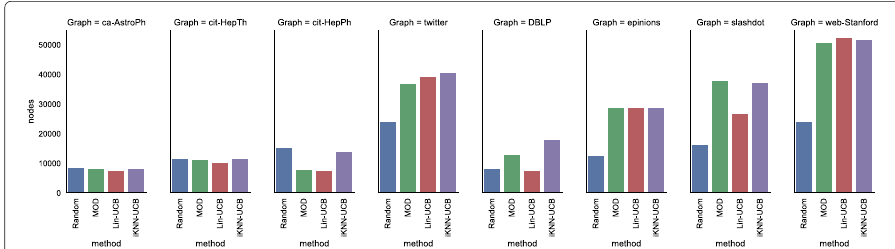
Fig. 8 Comparison against baselines: 1000 probes run on 5% nodes of each network. Each sample is created by performing a breadth first walk on the original